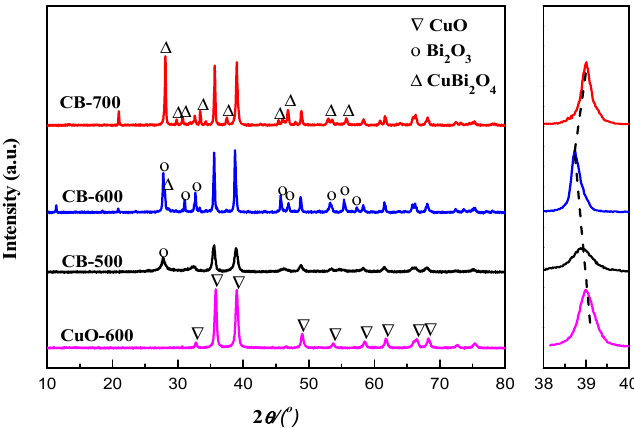
Figure 1. X-ray diffraction patterns (XRD) of the catalysts in this study. Table 1. Structural and textural data for the CuO-Bi 2 O 3 catalysts.